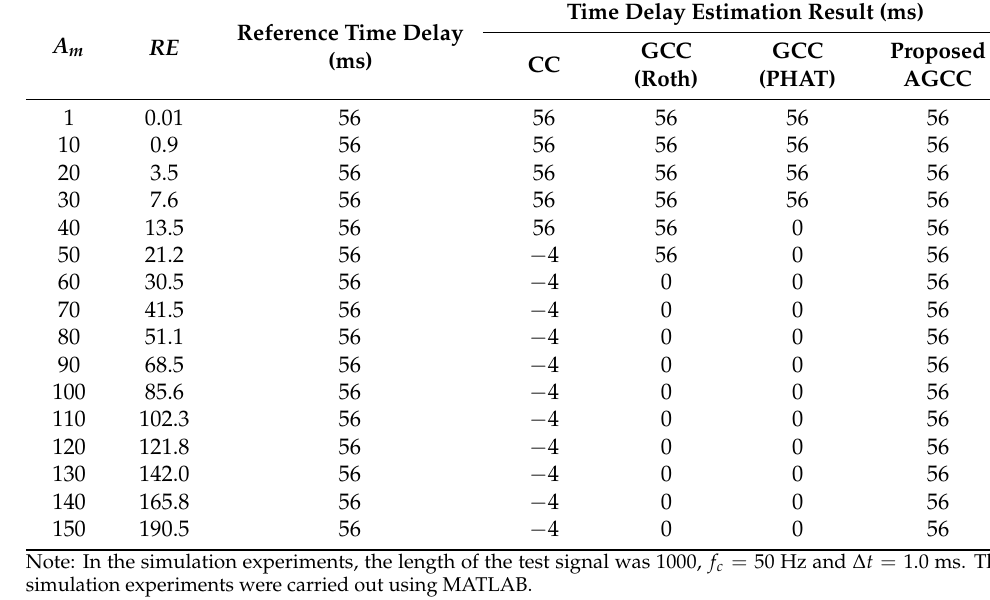
Table 1. Experimental results of the simulation experiments.